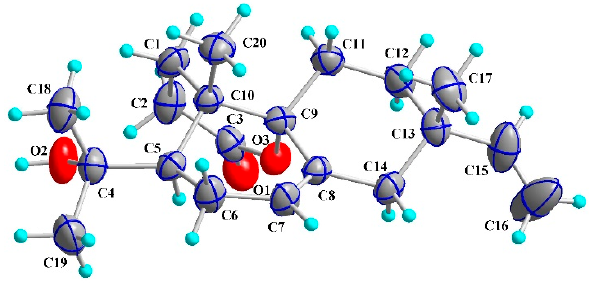
Figure 3. X-ray crystallographic structure of 1